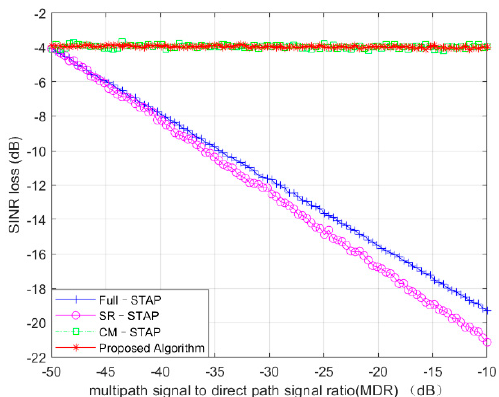
Figure 6. Performance with different multipath intensities.